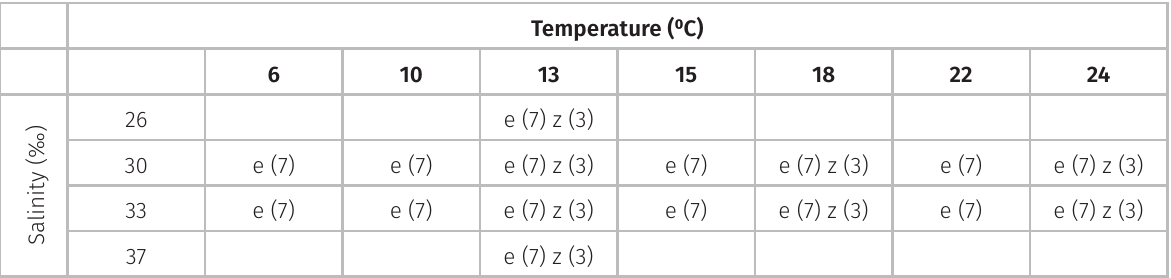
Table I. Experimental design. Set I of experiments (shadowed cells): Testing length of development, survival and fi tness of embryos (7 temperatures x 2 salinities) and zoeae I (3 temperatures x 2 salinities) of Ovalipes trimaculatus . Set II of experiments (thick framed cells): Testing length of development, survival and fi tness